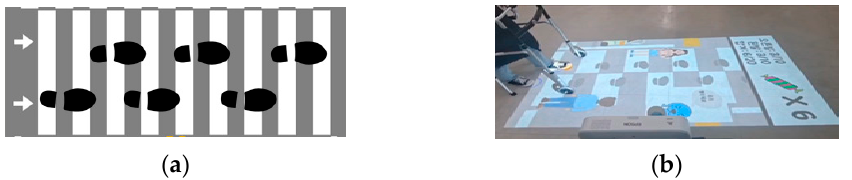
Figure 11. A usability evaluation: ( a ) a captured image of content used for the experiment; ( b ) a photograph of usability evaluation.